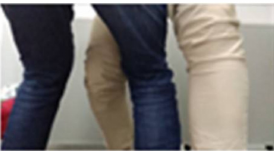
Figure 9. The legs move across each